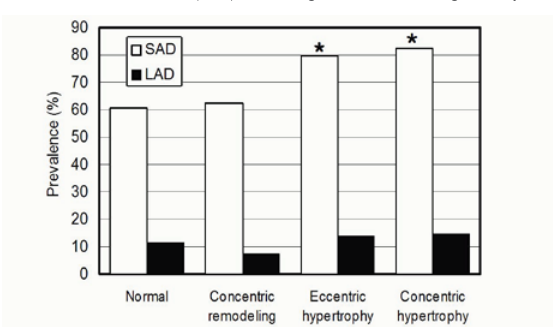
Group A- patients without either cerebral microbleeds or ischemic small-artery disease, group B- patients with ischemic small-artery disease but without cerebral microbleeds, group C- patients with cerebral microbleeds but without ischemic small-artery disease, group D- patients with coexistence of cerebral microbleeds and ischemic small-artery disease. For the comparison test among the four groups, the nonadjusted statistical level of significance of p<0.05 corresponds to a Bonferroni adjusted statistical significance of p<0.0083. *p<0.0083 vs. group A. SD: standard deviation; HDL: high-density lipoprotein; LV: left ventricle. Figure 1. Percentage of small-artery disease (SAD) and large-artery Figure 2. Percentage of various types of small-artery disease disease (LAD) according to left ventricular geometry. according to left ventricular geometry.